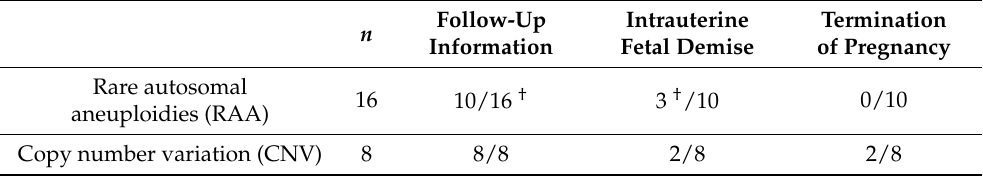
Figure 2. Flowchart of RAA positive cases and their clinical outcome. For 10 cases clinical outcome information was available. All NIPT results indicating the presence of a non-mosaic RAA had an adverse pregnancy outcome (T9, T10, T15, T16). The other RAAs presented in a mosaic form. † intra-uterine fetal death, ‡ true fetal mosaicism. Table 5. Clinical follow-up for RAA- and CNV-positive NIPT cases.